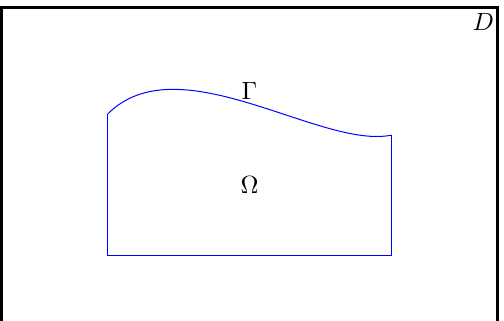
Figure 1. The geometry of the computational